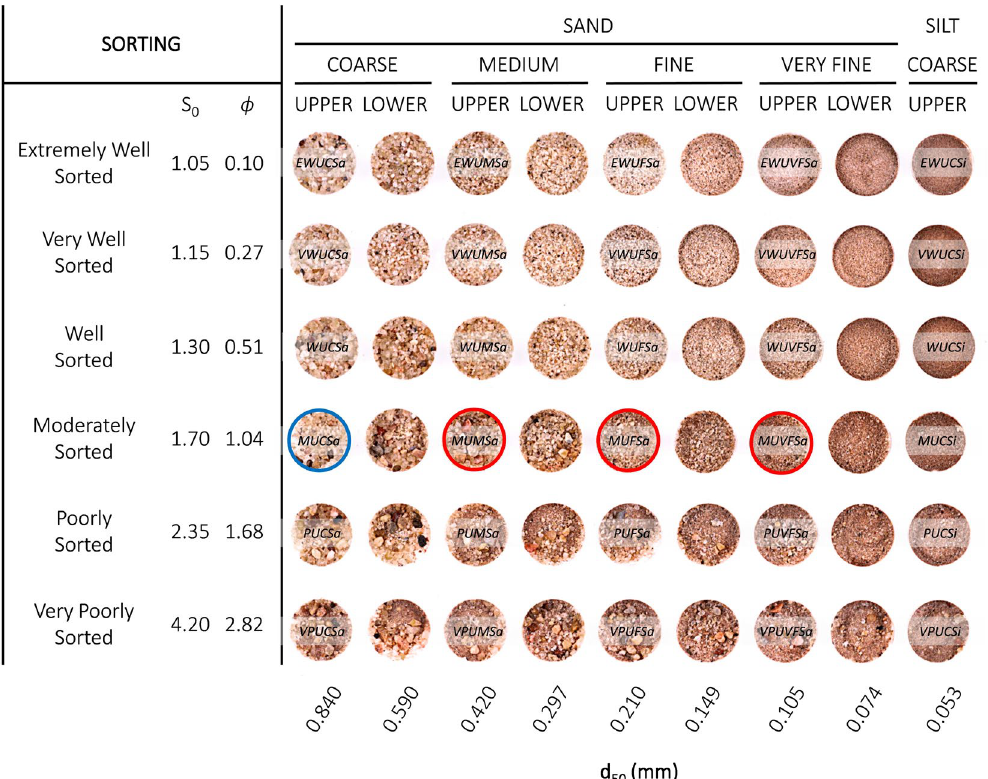
diagram output. For advanced users who want to understand the procedure which allows a 3D model output, the for loop beginning at line 32 of the modified code ( Model_Generator.m ) incrementally changes the input variable PHASEF, which is described by Rubin and Carter 26 as the bedform phase (in degrees). Changing PHASEF essen- tially specifies the horizontal position of the bedform within the fixed reference frame of the block diagram edges. By systematically changing this variable and retaining the vertical face of the block diagram output for each loop, serial sections of the model can then be concatenated to build a 3D digital model. Beyond the addition of simple looping, the modified code takes advantage of a built-in MATLAB function that is perhaps non-intuitive for 3D geologic model building. The modified script uses the ‘vec2mtx’ (line 106 of Model_Generator.m ) function, which is used in mapping applications and is available through MATLAB’s Mapping Toolbox. More specifically, the ‘vec2mtx’ function converts X-Y vectors (polygons) to a specified regu- lar data grid of binary values (zero or one). Practically, it allows for a continuous representation of depositional laminae in a gridded format, similar to pixelated (raster) representation of a map of political boundaries. This function is applied to each vertical section of the model during the looping of PHASEF described above. This mapping function is needed because the workspace variable representing the laminae on the block diagram faces is initially stored as a three column array representing coordinates of the laminae locations, and is not a regular- ized grid. For additional information about ‘vec2mtx’, the reader is referred to the MATLAB documentation and numerous online examples. For users familiar with the routines by Rubin and Carter 26 , the script published here contains comments on each line that represents a modification of the original script or new entry. The new script will produce an image of the model, but all scripting related to visual animation of bedforms in the original script has been eliminated for clarity and compactness. Since the original script contains standard comment notation, new and/or modified lines are identified in the new scripts by the use of four comment characters (%%%%). The comments provide a